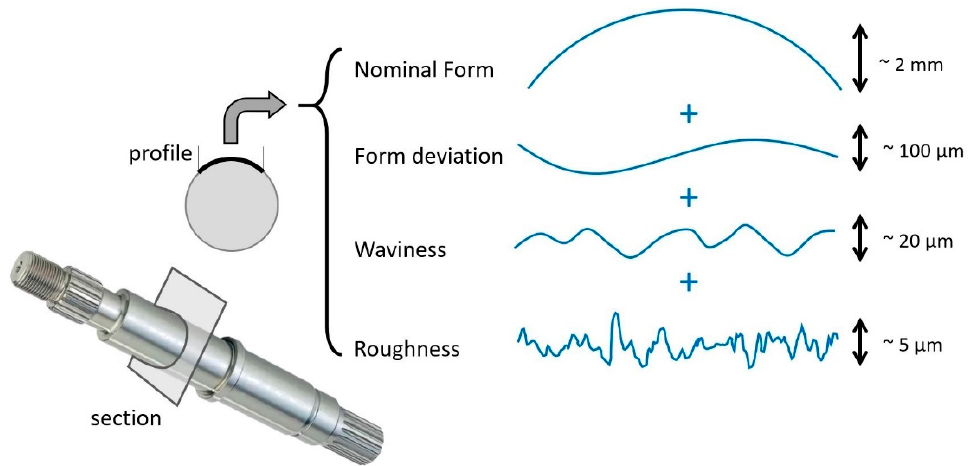
Figure 5. A schematic representation of the separation of deviations from nominal form into profiles of form deviation, waviness, and roughness.